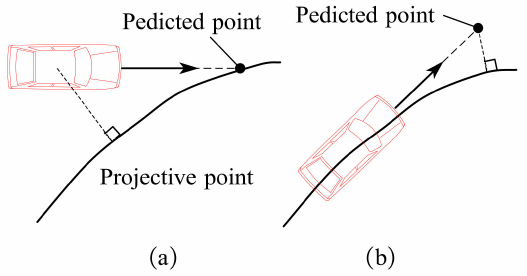
Figure 6. The relationship between predicted points and